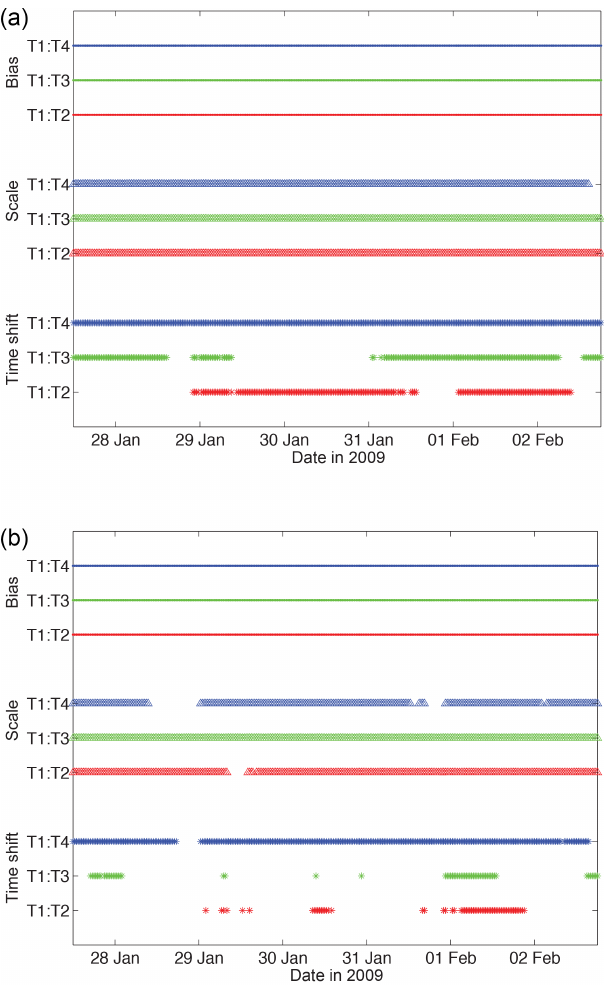
Figure 11. Significantly determined parameters; correlation length is 101 samples (a) or 51 samples (b)